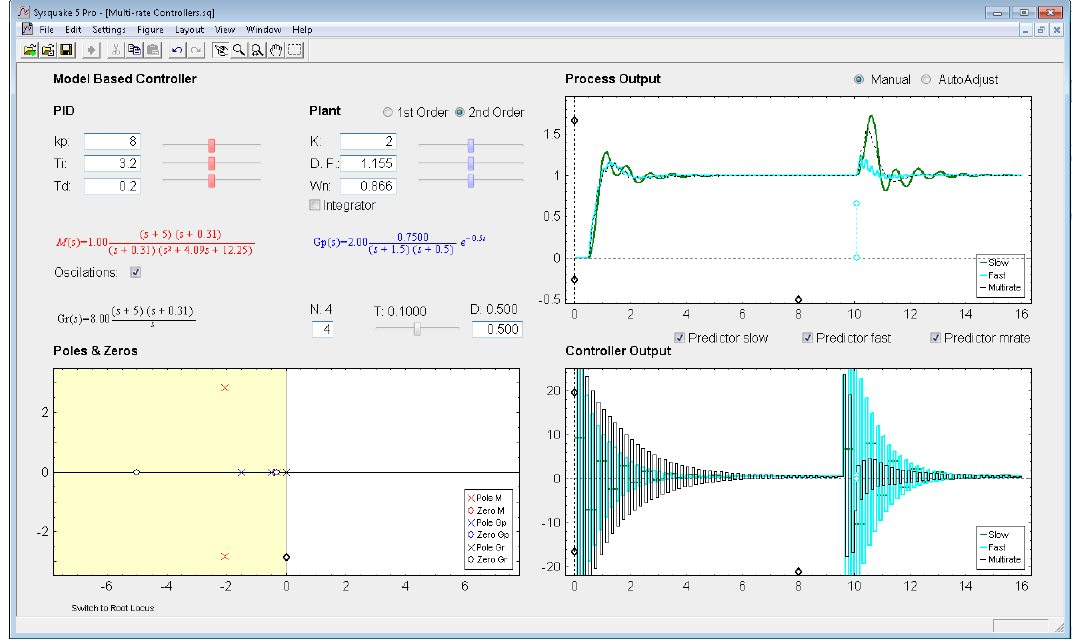
Figure 9. Application user interface for the Model-based (PID) controller.